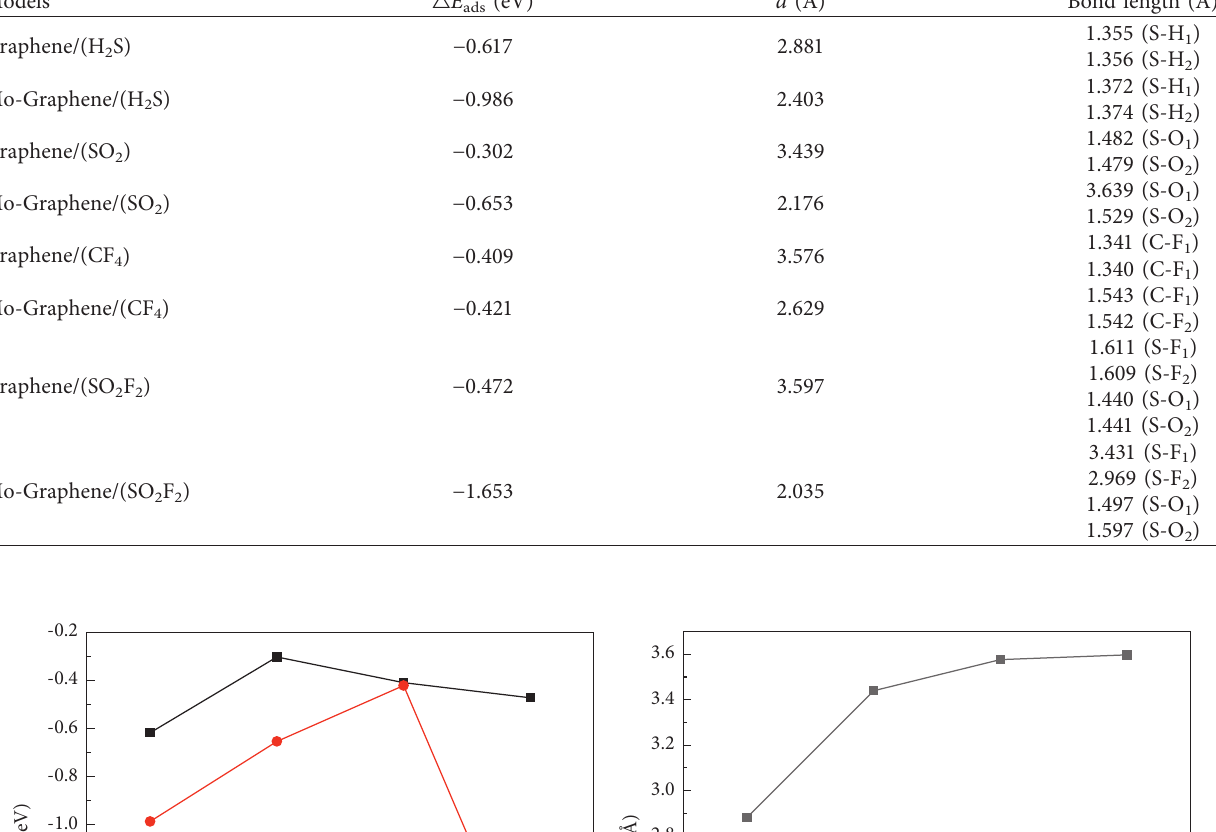
Table 2: Adsorption parameters of SF 6 and its substitute gas decomposition products on the surface of intrinsic graphene and Mo-doped T- site graphene.